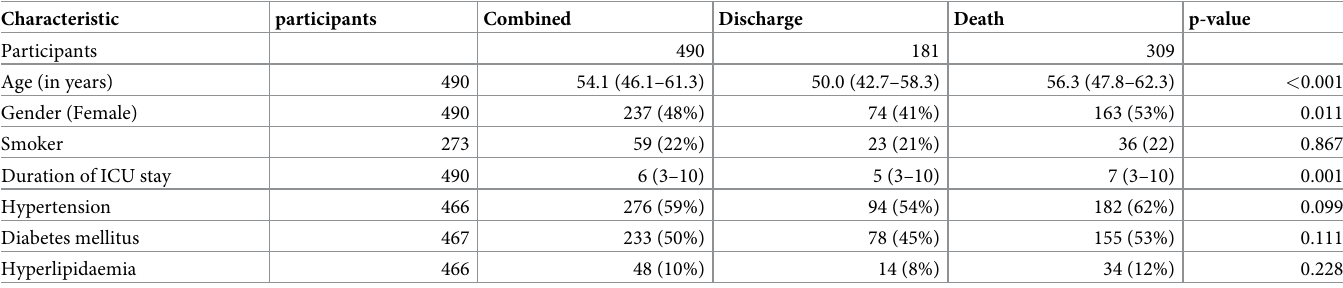
Table 1. Sociodemographic and risk factors of COVID-19 patients admitted to the